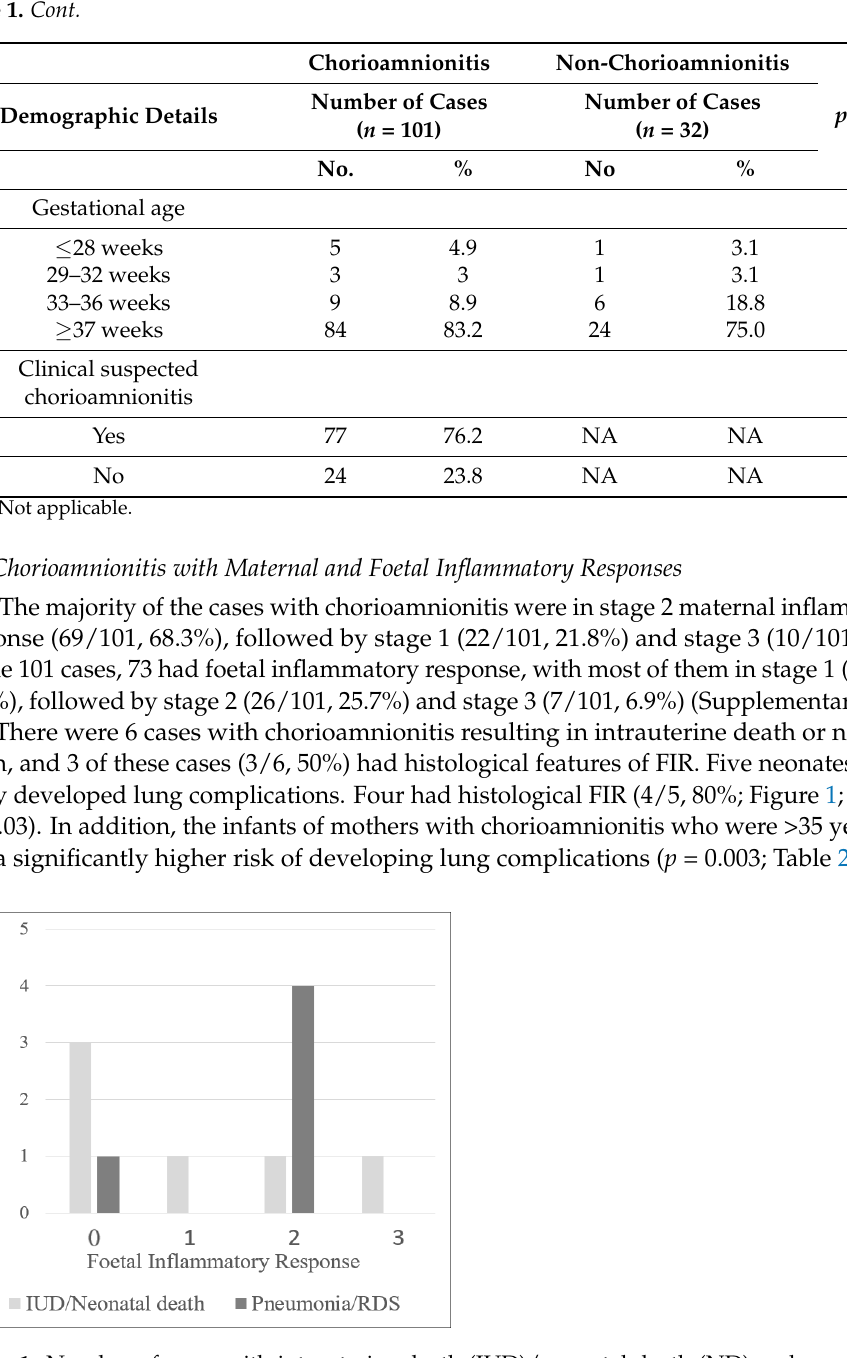
Figure 1. Number of cases with intrauterine death (IUD)/neonatal death (ND) and pneumonia/res- piratory distress syndrome (RDS) in relation to histologic foetal inflammatory response. Table 2. Correlation between clinicopathological parameters of cases with chorioamnionitis and their perinatal outcomes.